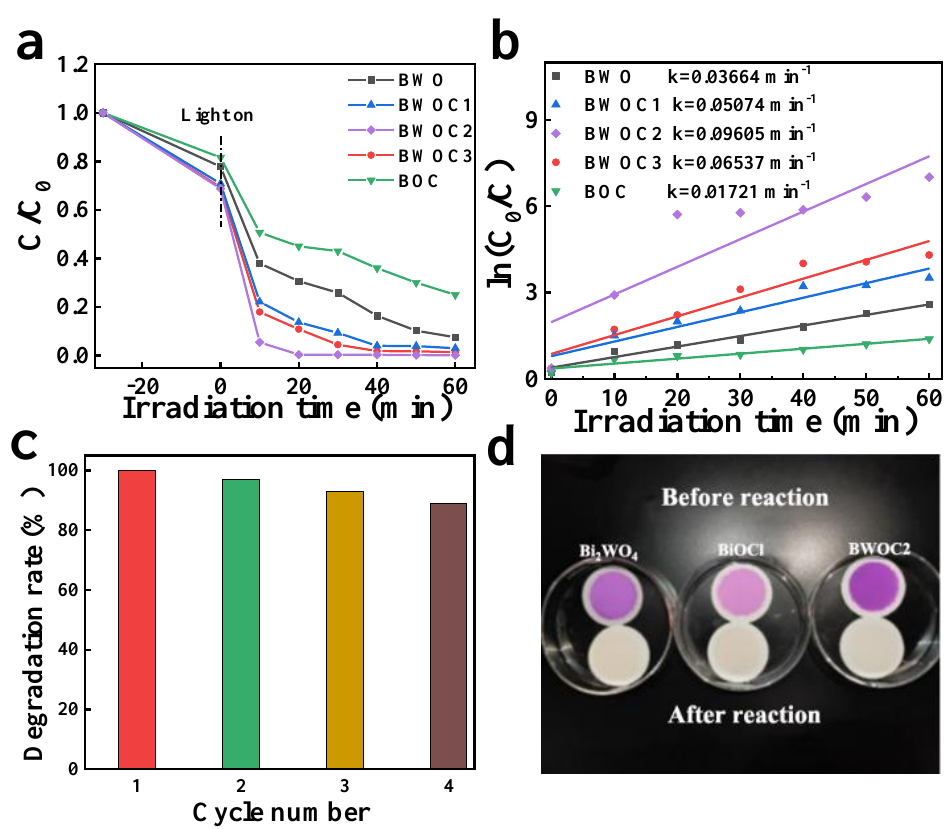
Figure 5. ( a ) Photodegradation curves, ( b ) ln( C 0 / C ) vs. time curves and rate constant, k , over different samples, ( c ) recycling tests of BWOC2 sample, and ( d ) color contrast of BWOC2 sample before and after the reaction.